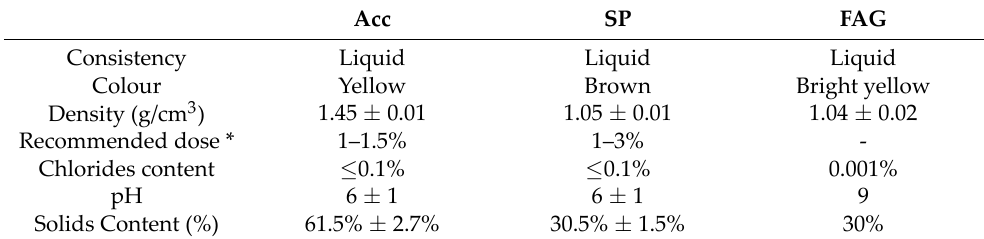
Table 2. Characteristics of admixtures used in the elaboration of BFC.